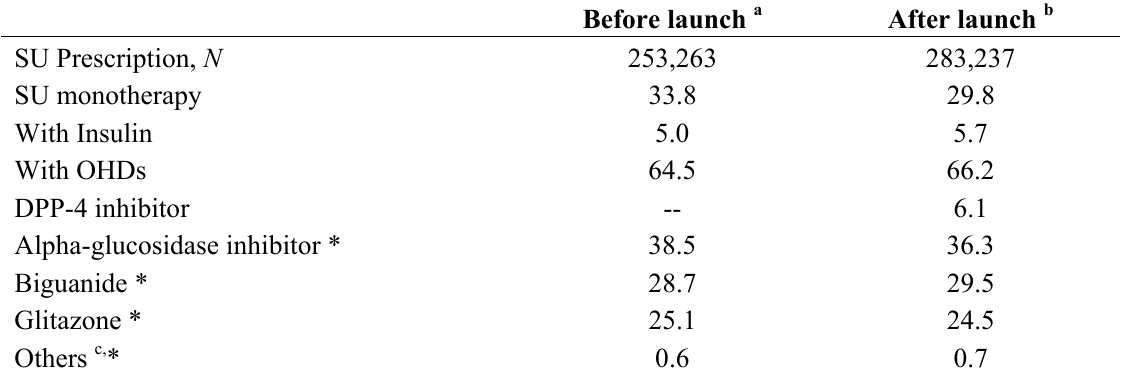
Table 2. SU and same-day co-prescription before and after the DPP-4 inhibitor launch in Japan. Before launch a After launch b SU Prescription,